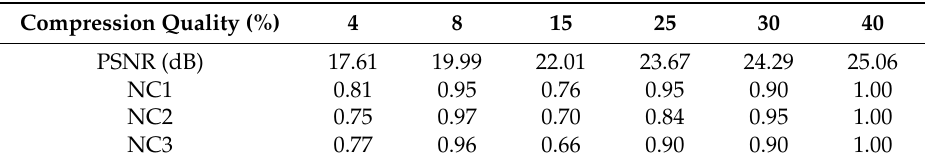
Figure 16. Under JPEG attacks: (a) Compression quality set to 4%; (b) the extracted watermark 1 with compression quality set to 4%; (c) the extracted watermark 2 with compression quality set to 4%; (d) the extracted watermark 3 with compression quality set to 4%; (e) Compression quality set to 25%; (f) the extracted watermark 1 under compression quality set to 25%; (g) the extracted watermark 2 under compression quality set to 25%; (h) the extracted watermark 3 under compression quality set to 25%. Table 4. Data of JPEG attacks.